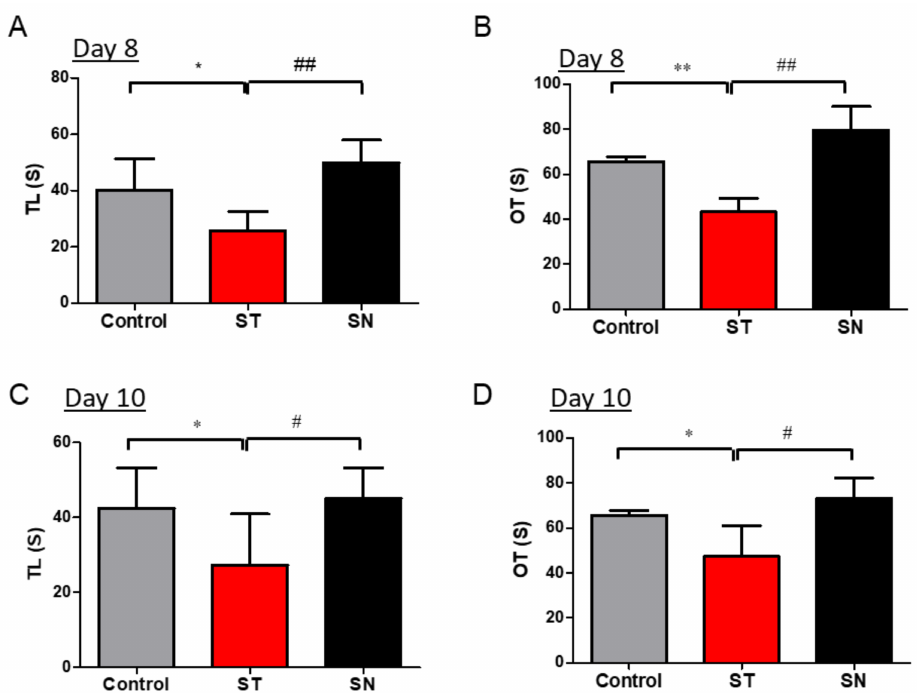
Figure 3. Treatment with EcN alleviates streptomycin-induced anxiety in C57BL/6 mice. Strepto- mycin (20 mg/day) was administered to mice from both ST and SN groups on day 1, and only the mice from SN were treated with EcN (1 × CFU) via oral gavage on days 3 and 6. The LDB ( A , C ) and EPM ( B , D ) tests were conducted on day 8 and day 10 to study anxiety-like behaviors. Data are expressed as the means ± SDs ( n = 7). * p < 0.05 and ** p < 0.01 for control vs. ST mice; # p < 0.05 and # # p < 0.01 for ST vs. SN mice. (EcN: Escherichia coli strain Nissle 1917; CFU: colony-forming units; LDB: light-dark box; EPM: elevated plus maze; TL: time spent in light chamber (in seconds); OT: time spent in open arms (in seconds); ST: streptomycin alone-treated group; SN: streptomycin- and EcN-treated group; SD: standard